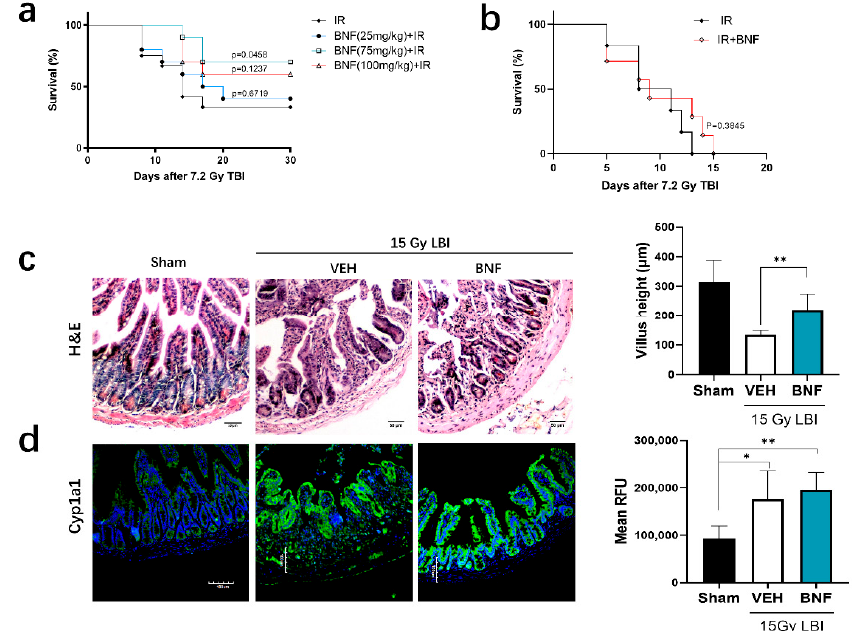
Figure 6. BNF protected mice from irradiation exposure. ( a ) Survival curves after 7.2 Gy of TBI. Mice ( n = 10) were treated with different doses of BNF daily for seven days prior to 7.2 Gy TBI. ( b ) Mice ( n = 6) were administered BNF at 75 mg/kg by gavage for seven days, on the seventh day mice were exposed to radiation, BNF treatment was continued for an additional five days, then monitored for 30 days. ( c ) H&E staining of jejunum cross-section and quantification of the villus height in jejunum. Mice were administered BNF (75 mg/kg) or vehicle by gavage daily for seven days prior to 15 Gy LBI irradiation.; ( d ) immunofluorescence of CYP1A1 protein levels in the jejunum of LBI irradiated mice and semi-quantification of fluorescence imaging of CYP1A1 expression. Results are expressed as Mean ± SD and analyzed by one-way ANOVA (Significance: * p < 0.05, ** p < 0.01).